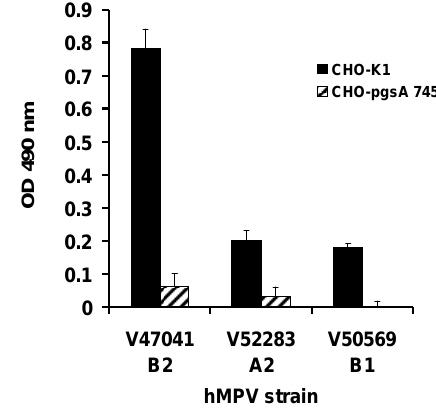
Figure 1. Primary isolates of hMPV utilise GAGs to mediate infection. CHO-K1 and CHO-pgsA 745 cells were inoculated with hMPV PCR positive nasopharyngeal aspirates. LLC-MK2 cells were inoculated with the CHO cell supernatants and infectivity determined by cell ELISA using a hMPV matrix protein mAb. Data represent mean values ± SD of triplicate